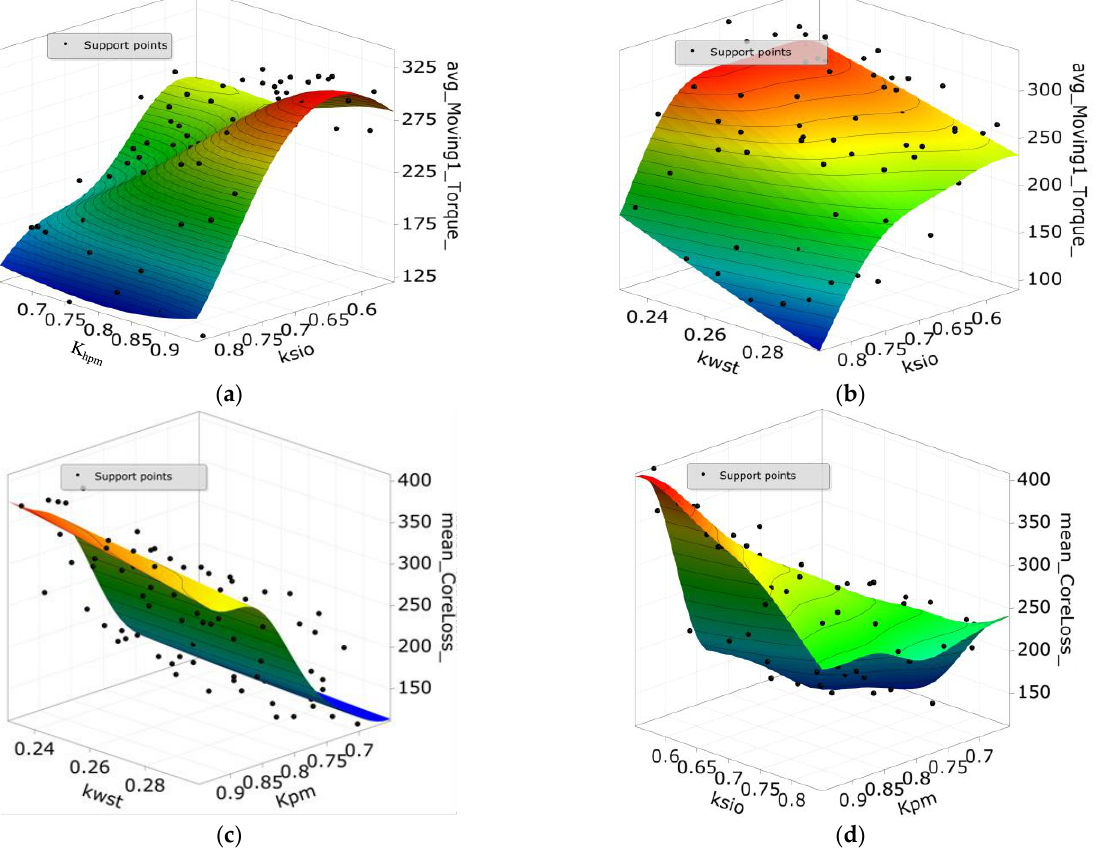
Figure 7. RS analysis of and Core loss distributions with inputs. ( a ) RS of torque distributions with K hpm and k sio . ( b ) RS of torque distributions with k wst and k sio . ( c ) RS of Core loss distributions with K hpm and k wst . ( d ) RS of Core loss distributions with K hpm and k sio.